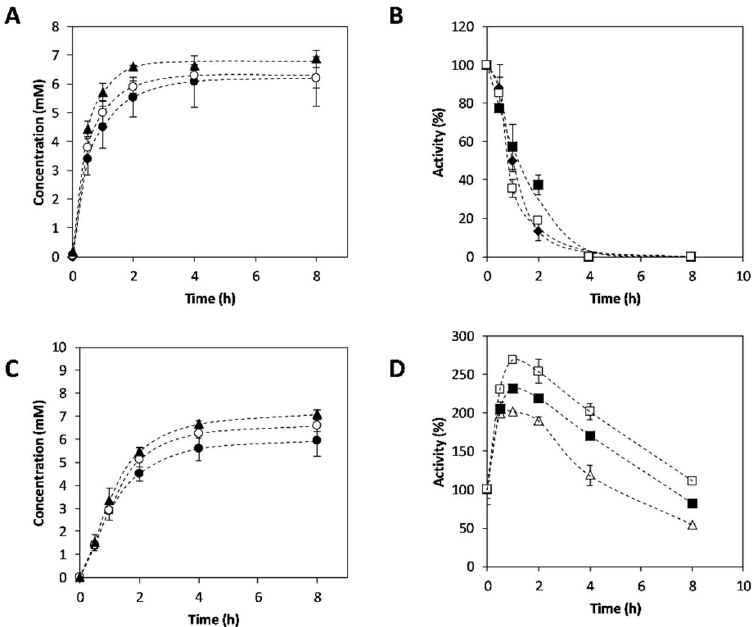
Figure 6. L-Alanine concentration effect on 3-APB synthesis and on operational enzymatic stability.